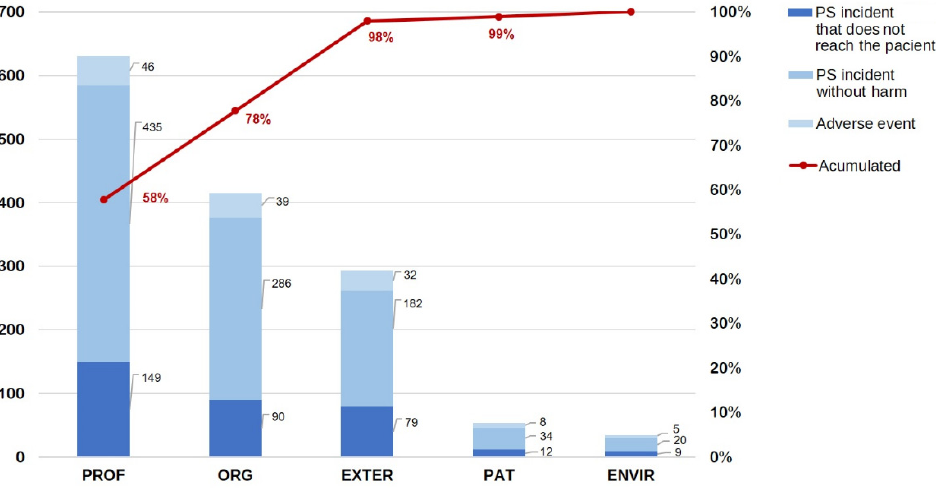
Table 4. Distribution of the type of incidents reported according to the resolution